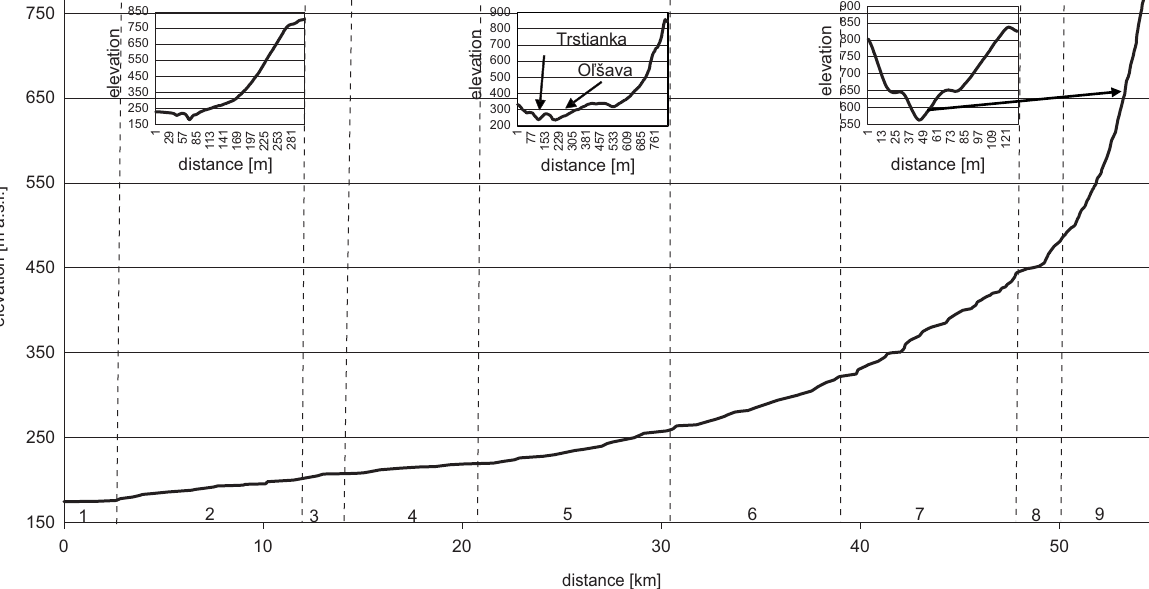
fig. 2. The longitudinal profile of the Oľšava river valley showing the boundaries of the assessed segments. The top of the figure depicts transverse profiles of the Oľšava valley documenting the change in the width of the valley and its